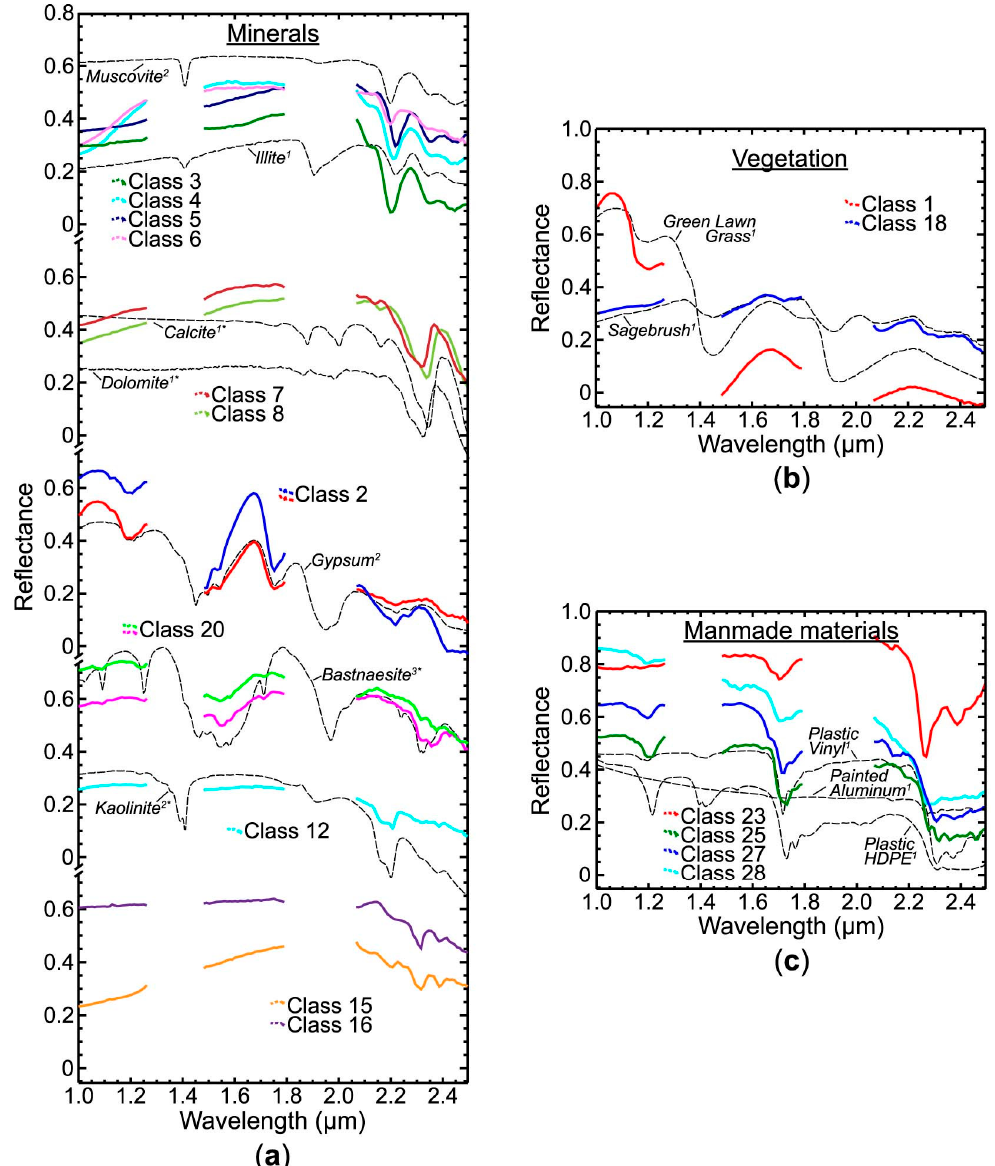
Figure 7. Selected shortwave infrared (SWIR) image endmember spectra and reference spectra of: ( a ) mineral phases; ( b ) vegetation; ( c ) manmade materials. 1 USGS Digital Spectral Library [61];